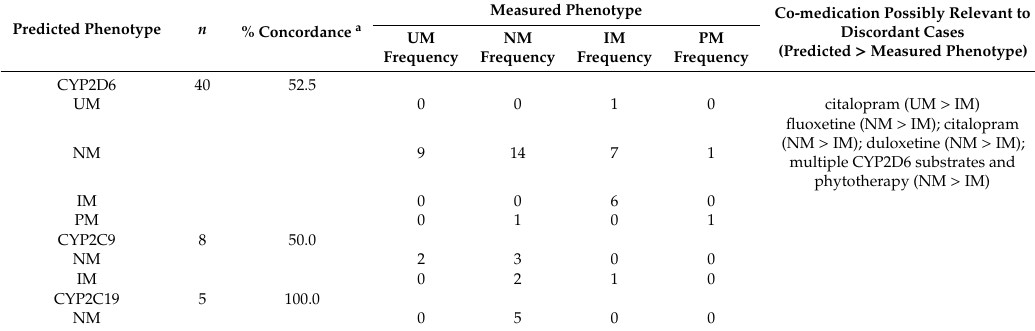
Table 4. Concordance between phenotype predicted from genotype and measured